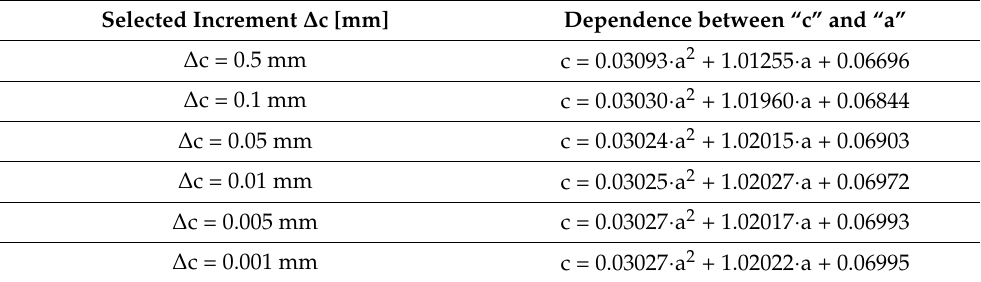
Table 4. Dependence between “c” and “a” for thickness of flange t f = 10 mm depending on incre- ment ∆ c.